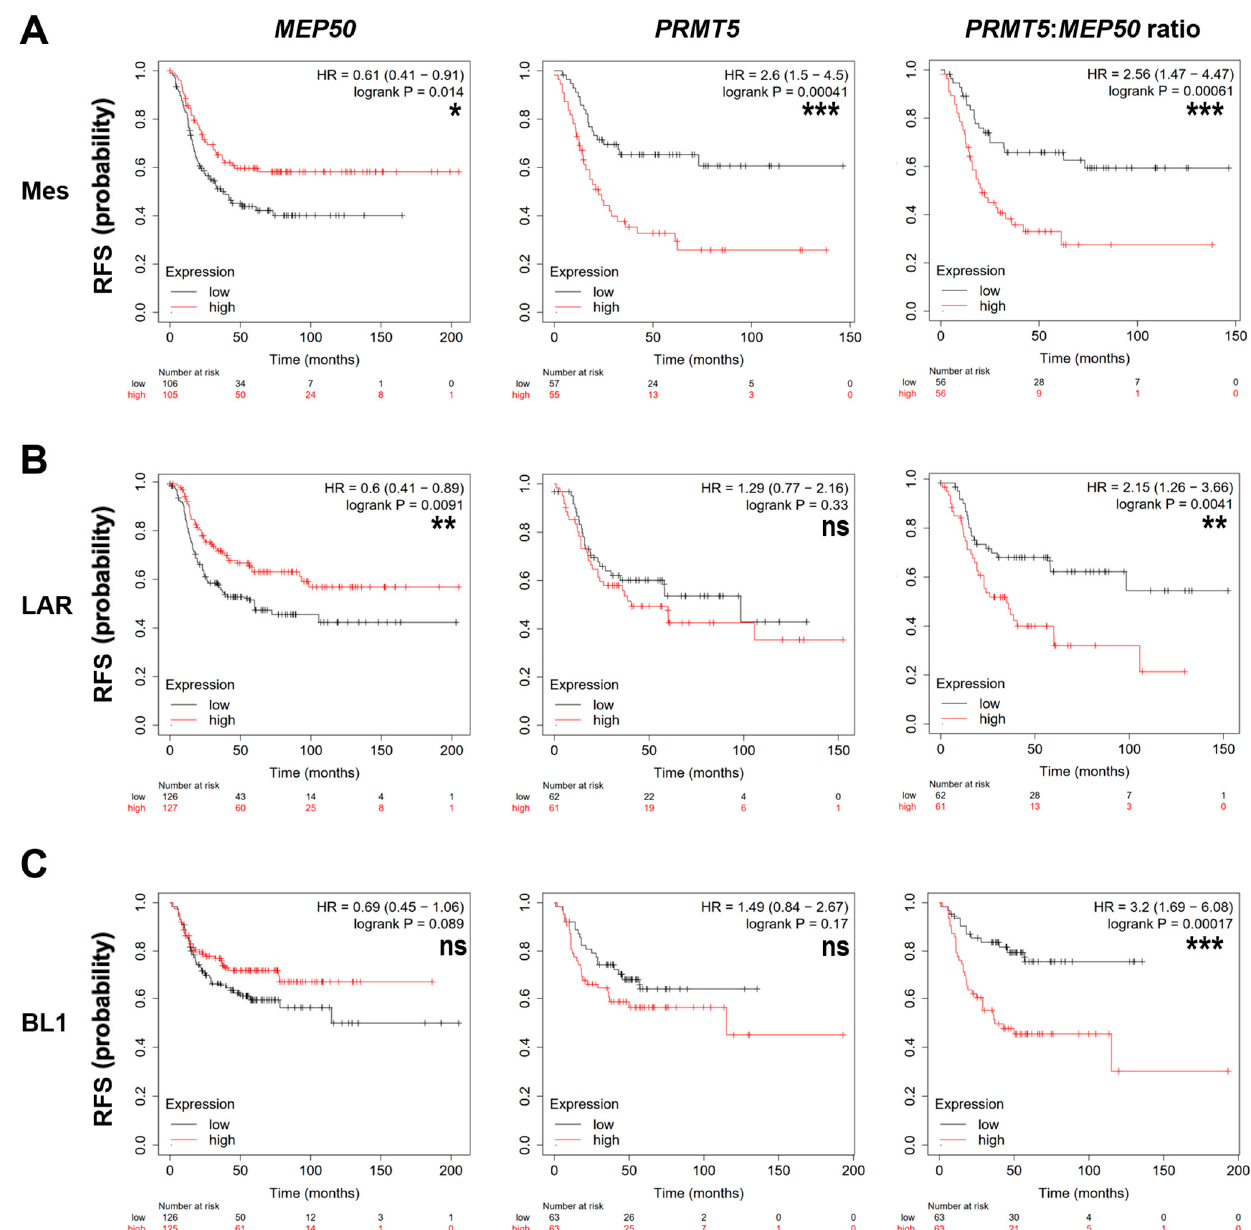
Figure 3. High PRMT5:MEP50 mRNA ratio is associated with worse RFS in mesenchymal, LAR and BL1 TNBC subtypes. ( A – C ). RFS based on MEP50 or PRMT5 mRNA expression or PRMT5:MEP50 mRNA ratio were obtained from the Kaplan–Meier (KM) plotter website (http: //kmplot.com) for mesenchymal (Mes; ( A )), luminal androgen receptor (LAR; ( B )), and basal-like 1 (BL1; ( C )) TNBC subtypes. Of note, more patients were retrieved with MEP50 probe set compared to the PRMT5 probe set (Table 4). The obtained Hazard Ratio (HR) with 95% confidence interval and log-rank p -values are shown. ns (not significant), * p < 0.05, ** p < 0.01, *** p <